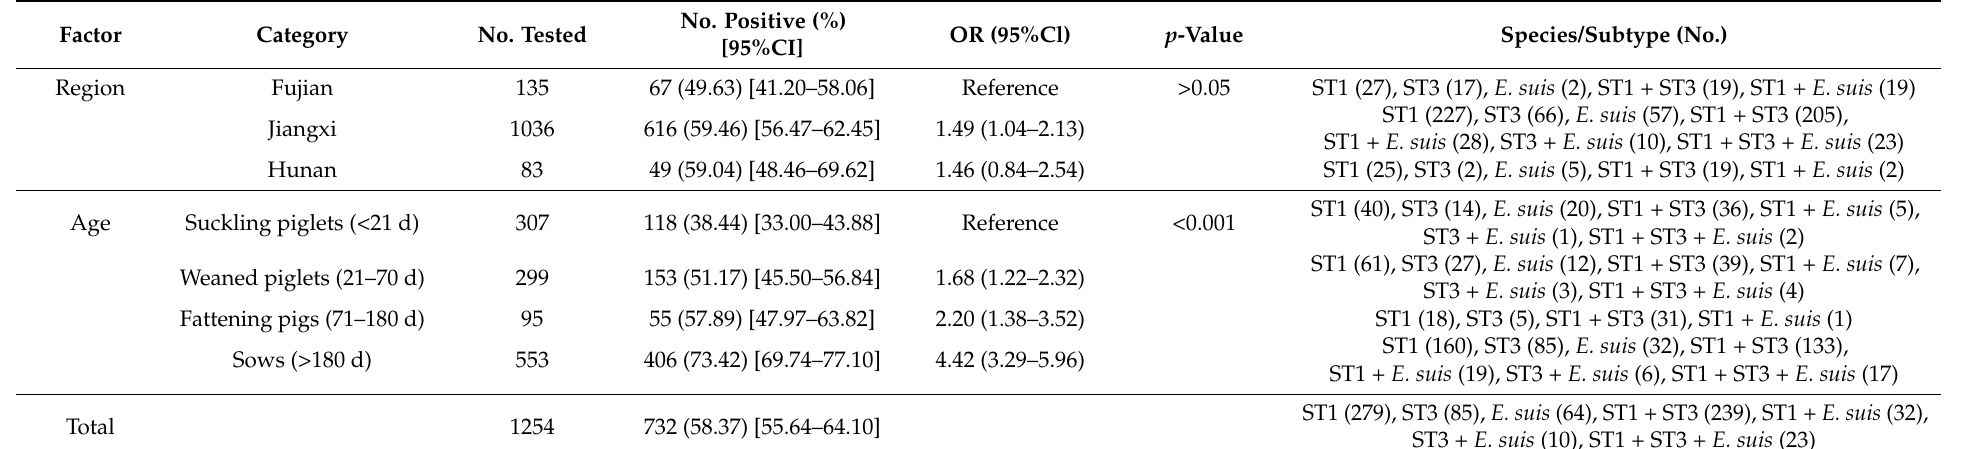
Table 1. Factors associated with prevalence and genetic characterizations of Entamoeba